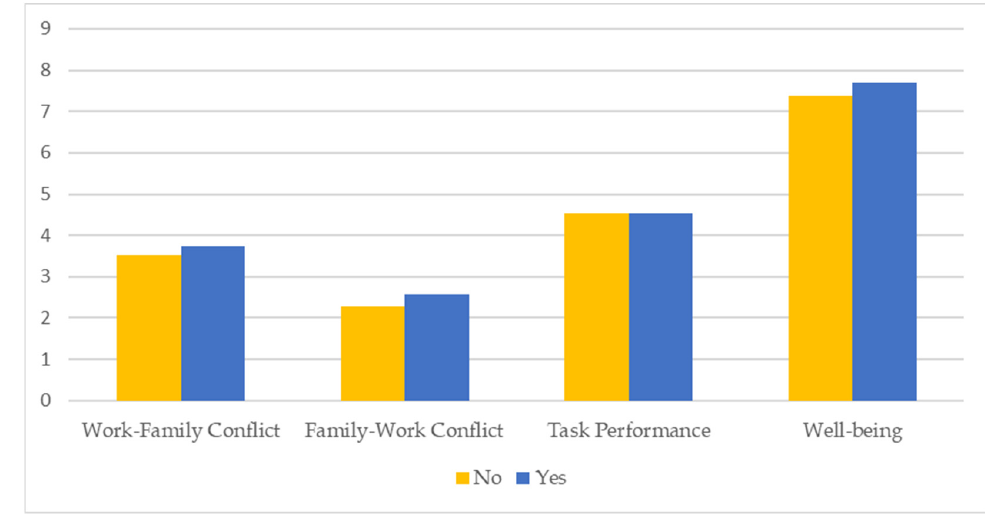
Figure 9. Distribution of variables according to hours exemption or not .